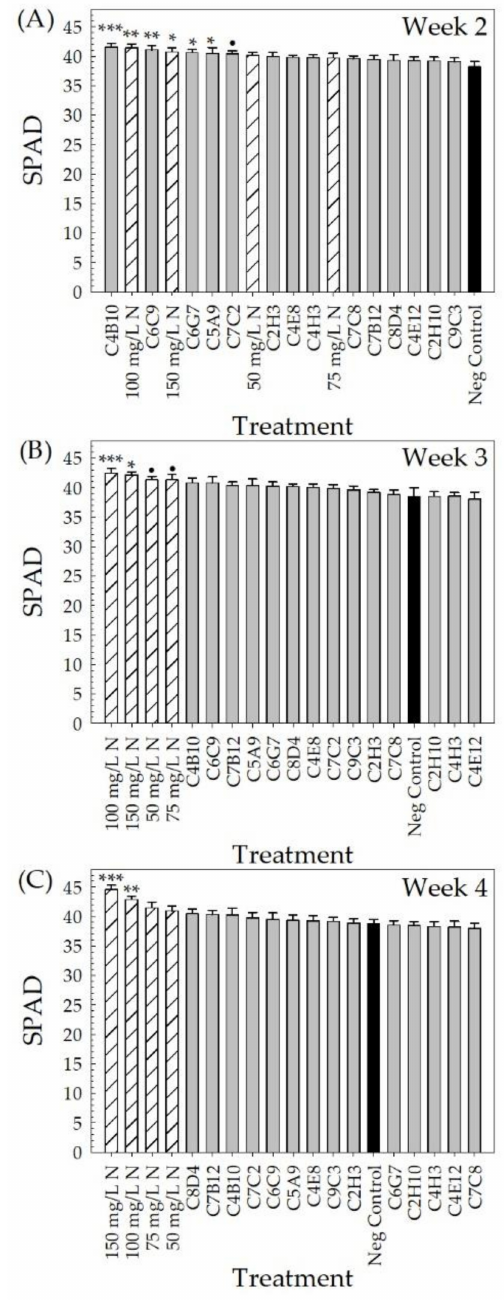
Figure 8. Relative chlorophyll concentration measured with the SPAD index in the greenhouse vali- dation trial after application of the 14 bacterial strains selected from the high-throughput greenhouse trials to Petunia × hybrida ‘Picobella Blue’ ( n = 12). SPAD index measurements are shown for two ( A ), three ( B ), and four ( C ) weeks after transplant. All plants treated with bacteria were fertilized with 25 mg L − 1 N (gray bars). The black bar represents the negative control (no bacterial treatment) fertilized with 25 mg L − 1 N, and the white bars with slanted lines represent the four positive controls (no bacterial treatment) fertilized with either 50, 75, 100, or 150 mg L − 1 N. The treatments were compared to the negative control using Dunnett’s comparison. Significance is represented by • , *, **, and *** at p ≤ 0.1, p ≤ 0.05, p ≤ 0.01, and p ≤ 0.001, respectively. Bars represent the mean, and error bars denote standard